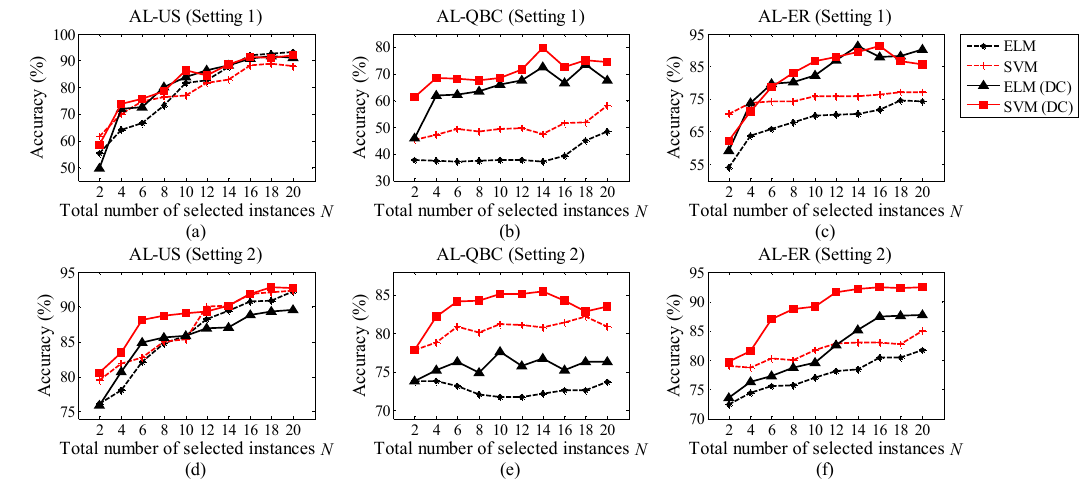
Figure 4. ( a ) Accuracy of AL-US-type methods in Setting 1; ( b ) accuracy of AL-QBC-type methods in Setting 1; ( c ) accuracy of AL-ER-type methods in Setting 1; ( d ) accuracy of AL-US-type methods in Setting 2; ( e ) accuracy of AL-QBC-type methods in Setting 2; ( f ) accuracy of AL-ER-type methods in Setting 2.